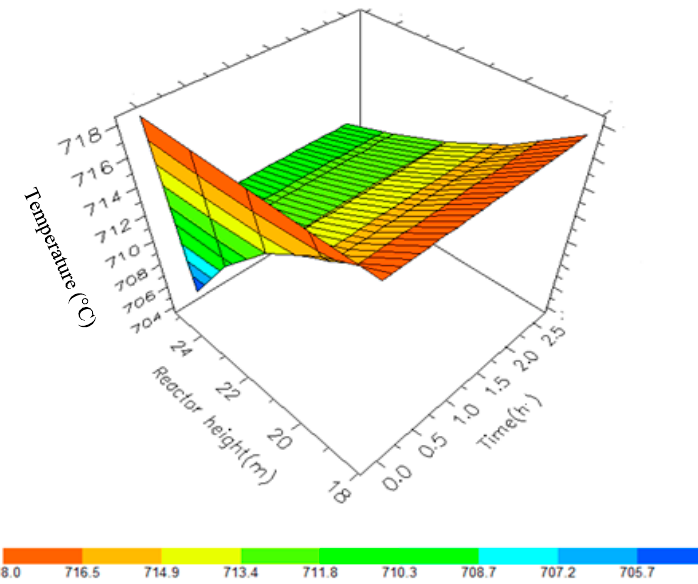
Figure 13. A 3D representation of Reactor 4 Temperature variation with reactor height and time.